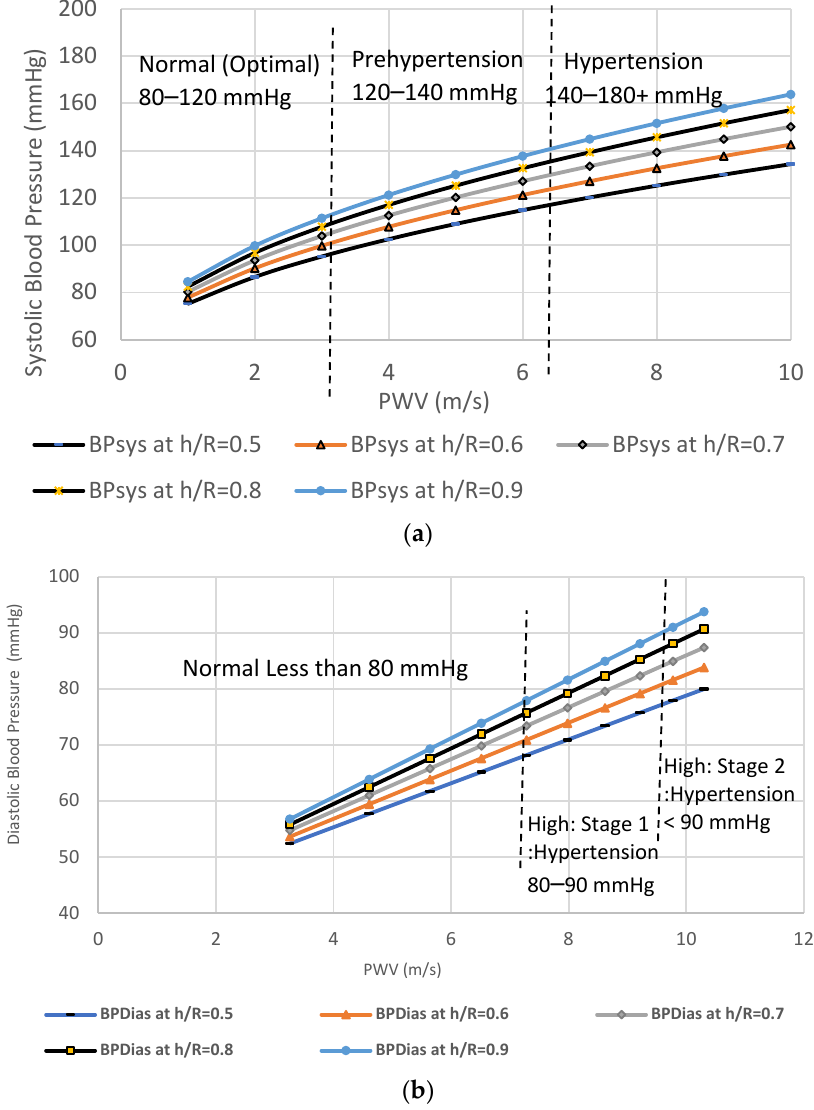
Figure 19. Blood pressure P versus normalized PWV for human brachial artery. The absolute risk of arterial blood pressure increased in relation to artery PWV.